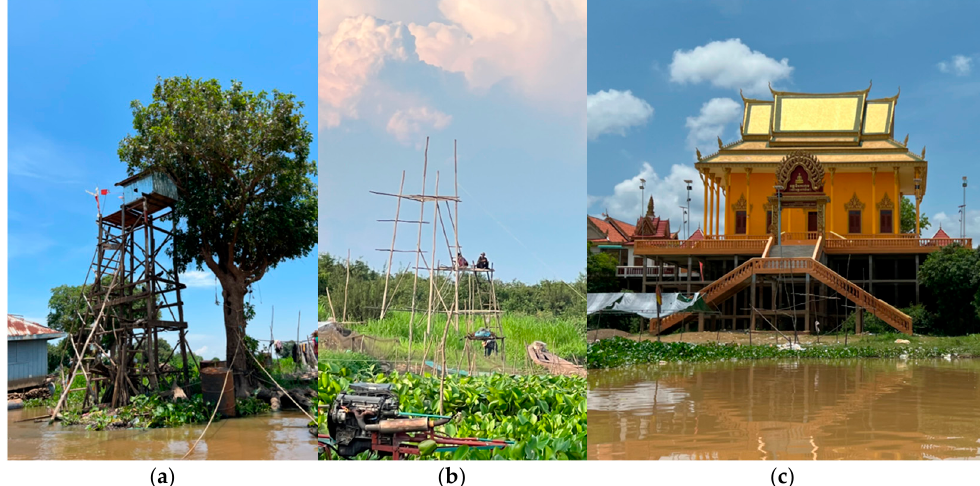
Figure 5. Prei ktom neak ta and wat . The small, impermanent form with perishable materials (wood and bamboo) of the ktom neak ta reveal a humble attitude of humankind towards nature. The strategic location of the spirit houses is between phum and prei and is an intensely utilized space for fishing, cultivation, and inhabitation. Meanwhile, the dominant size and permanence of the wat strongly differentiate it from its surroundings. From left to right: ( a ) Prei ktom neak ta in Daun Sdeung village; ( b ) reconstruction in Pichakrei village; and ( c ) the wat in Pov Veuy village. (Linh Vu, April 2022).